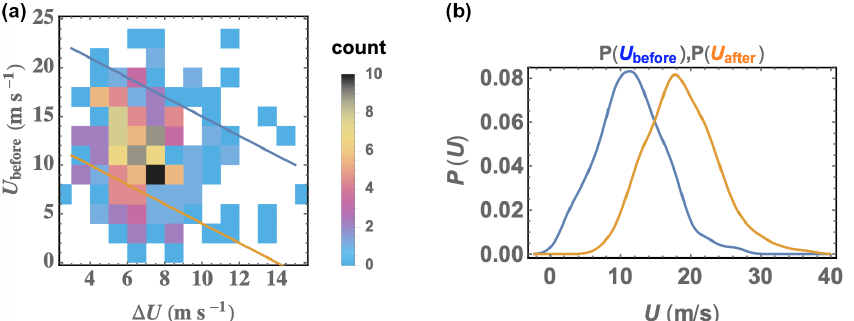
Figure 6. (a) Joint distribution of ramp amplitude and speed before ramp; points above blue line are above cutout (rejected), and points below yellow line do not cross from below to above V rated . (b) Distribution of speed before and after ramp